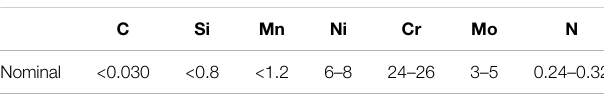
TABLE 1 | Chemical composition of UNS S32750 SDSS (%) as per ASTM A240.